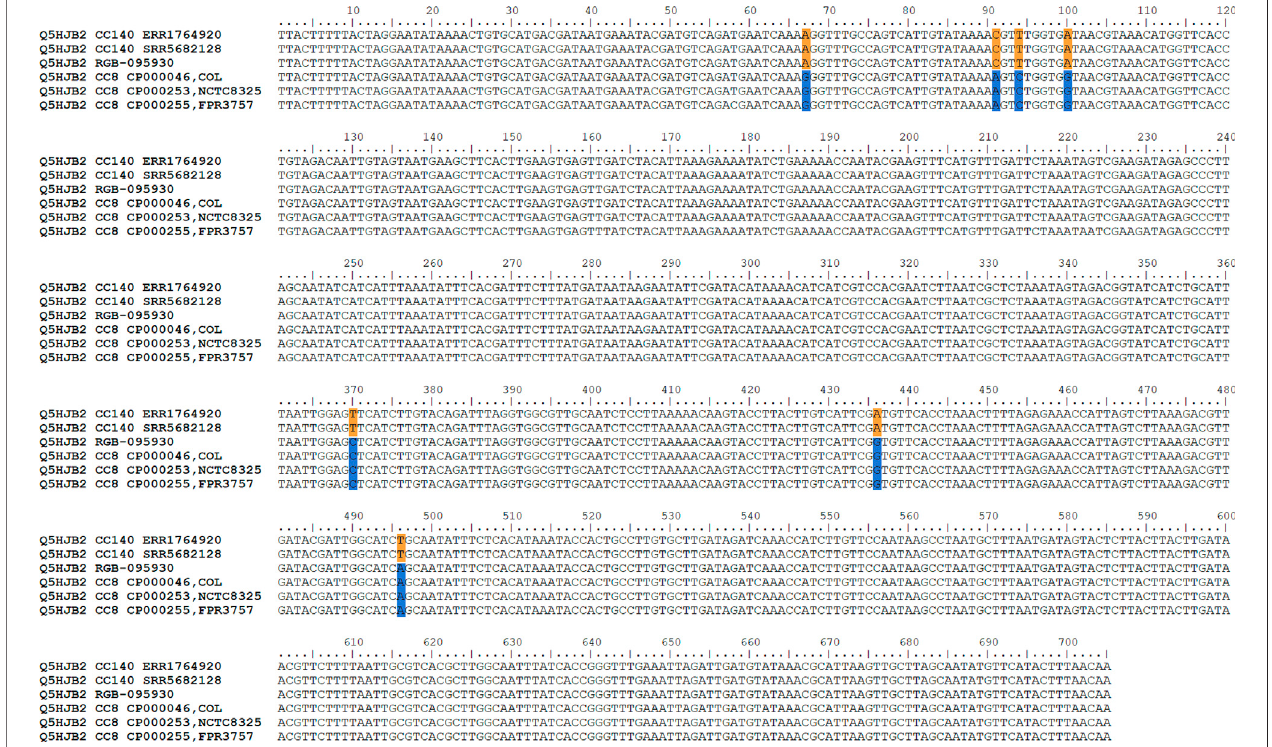
Frontiers in Genetics |